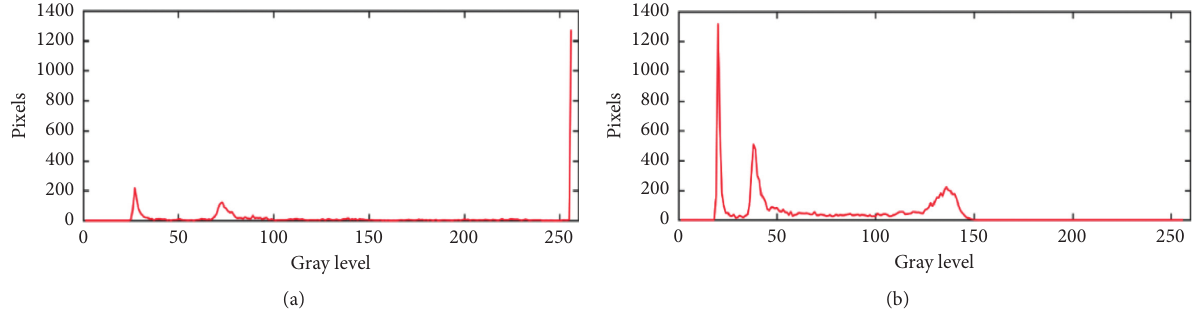
Figure 9: Comparison result of the gray histogram: (a) gray histogram of the image in Figure 8(a); (b) gray histogram of the image in Figure